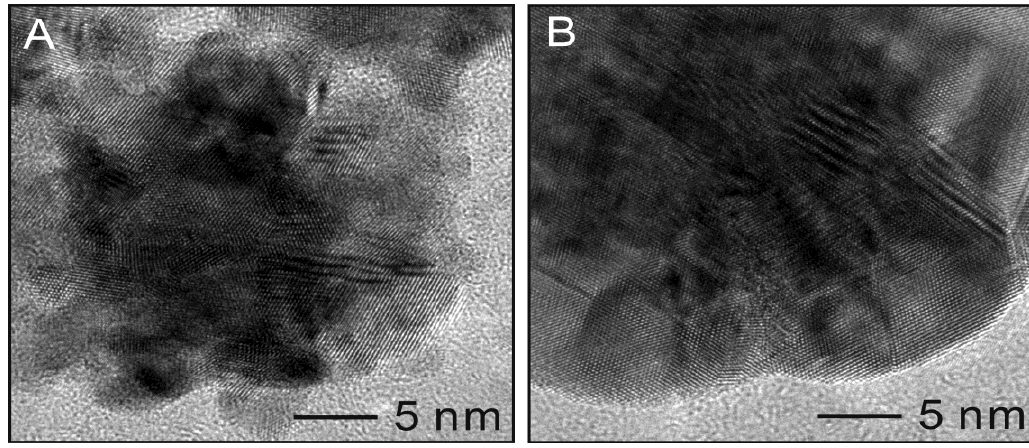
@Ag NP ( B 25.7 8.1